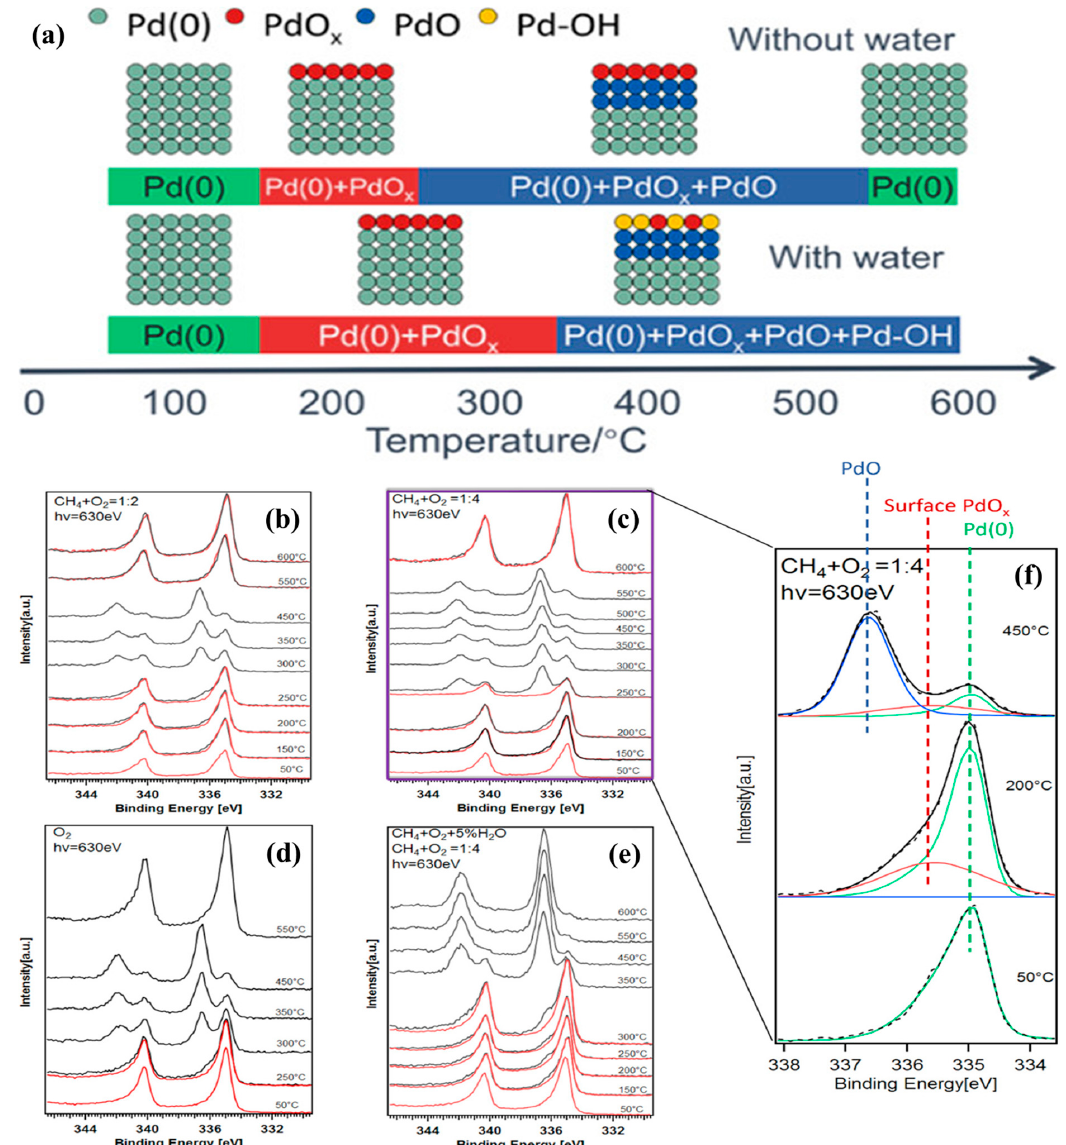
Figure 12. ( a ) The formation process and role of water on the structure of palladium catalyst. Steady- state Pd 3d photoemission spectra in gas atmosphere of ( b ) CH 4 + O 2 = 1:2, ( c ) CH 4 + O 2 = 1:4, ( d ) O 2 only, ( e ) CH 4 + O 2 + 5 vol% H 2 O (CH 4 + O 2 = 1:4) at different temperatures; and ( f ) deconvolution of